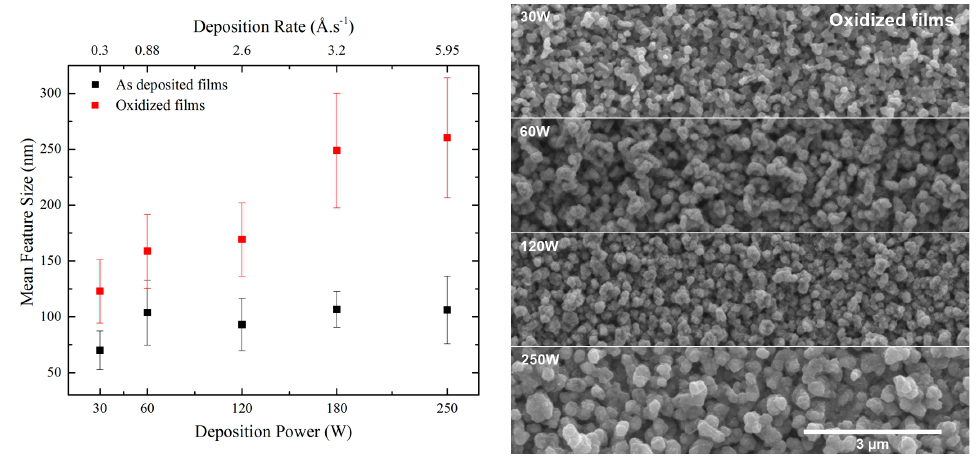
Figure 1. Mean feature size in function of power and rate deposition for metallic and oxidized films ( left ). Top view SEM images of films synthetized with different deposition powers ( right ).